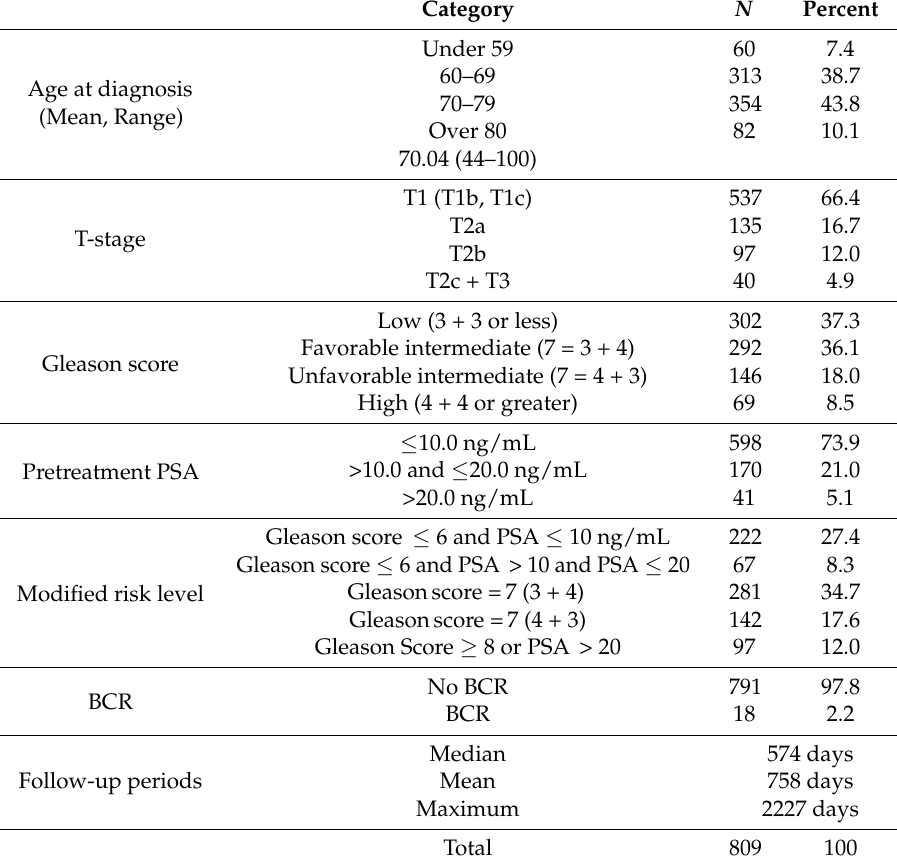
Table 1. Demographics of 809 patients. BCR: biochemical recurrence; PSA: prostate specific antigen.